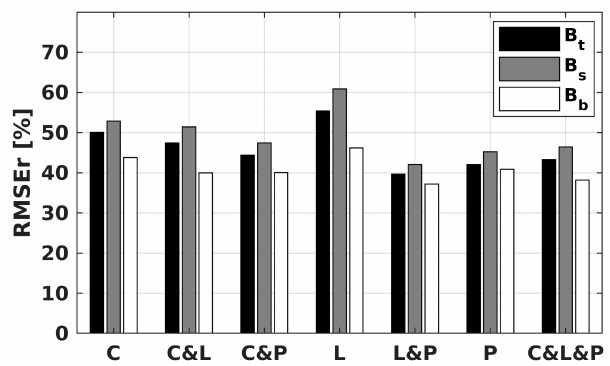
Figure 7. Relative RMSE for estimates of total above-ground, stem, and branch biomass derived from di ff erent combinations of multi-temporal C-, L-, and